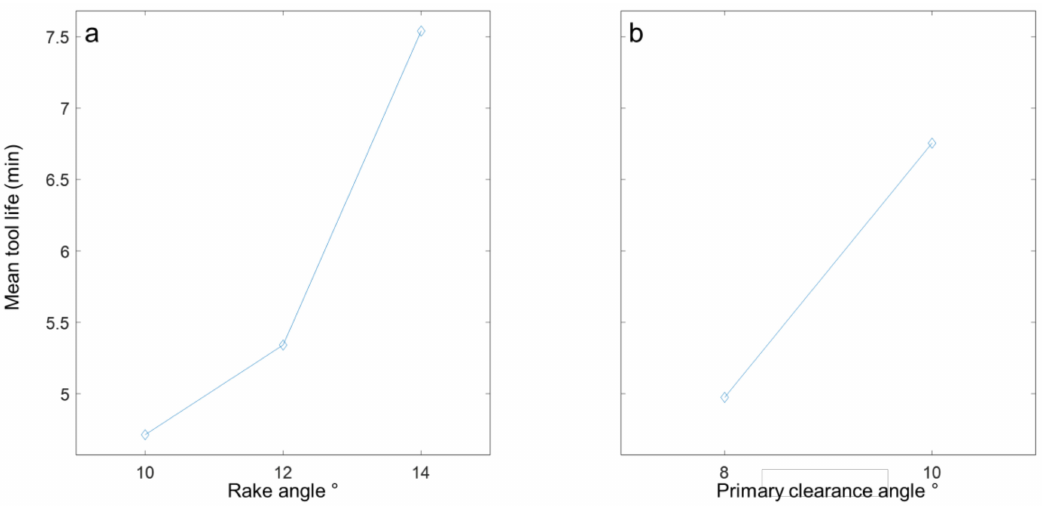
Figure 4. Main effect plots showing the effect of ( a ) rake angle and ( b ) primary clearance angle on tool life. Table 2. ANOVA of the results for tool life based on rake and primary clearance angles. Source Sum of squares Degree of freedom Mean